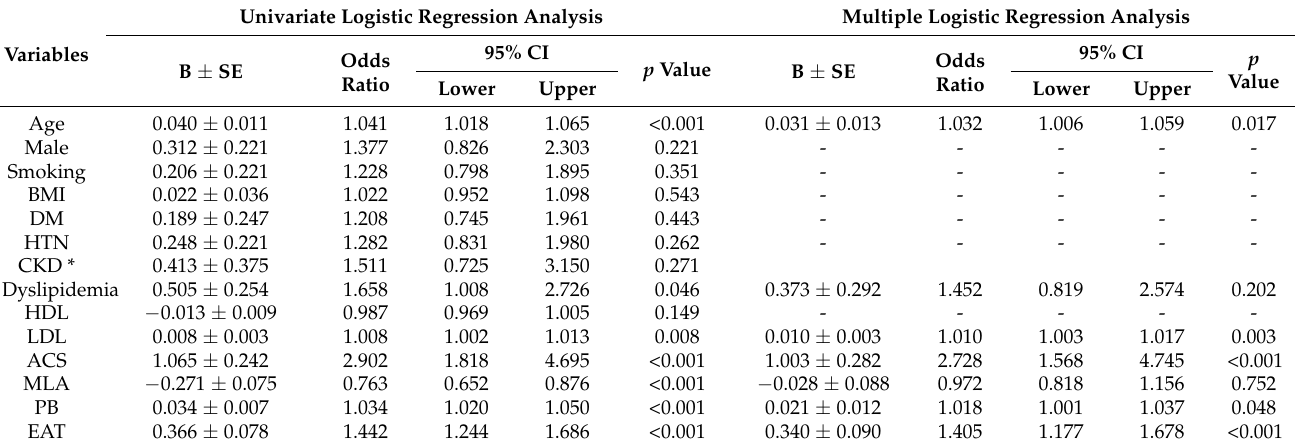
Table 3. Univariate and multivariate logistic regression analysis for independent predictors of max LCBI 4mm ≥